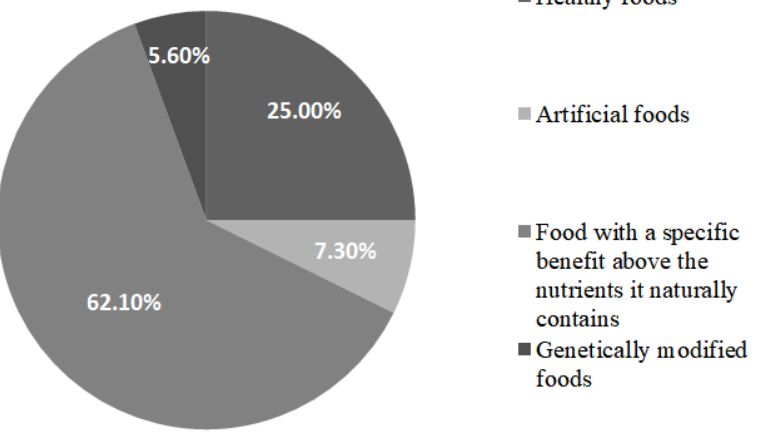
Figure 2. Participants’ interpretation of functional food ( n = 356).